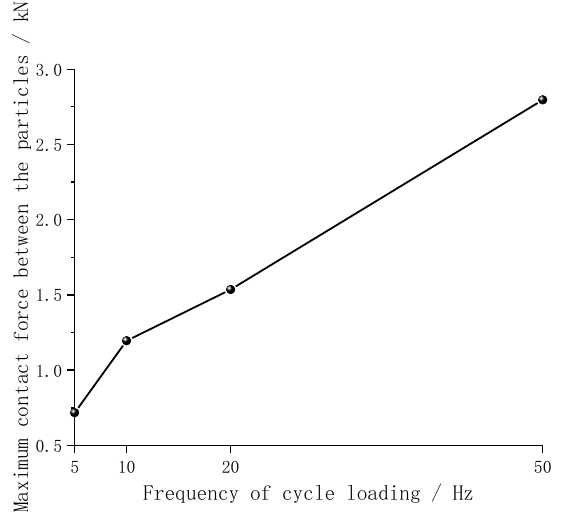
Figure 10. Relationship between the maximum contact force of the particles and the loading fre- quency.